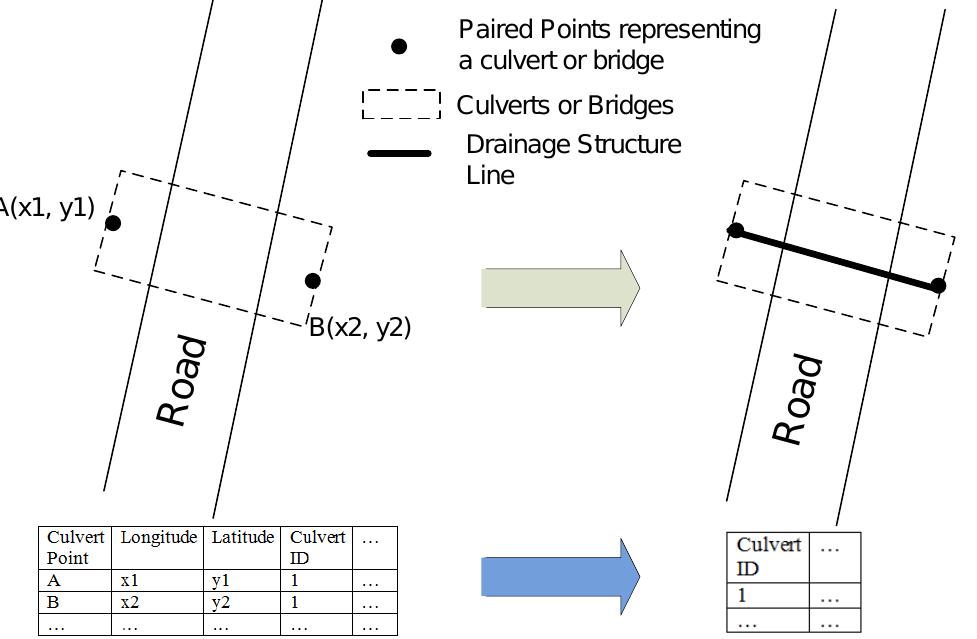
Figure 1. Conversion of point features to line features for a drainage